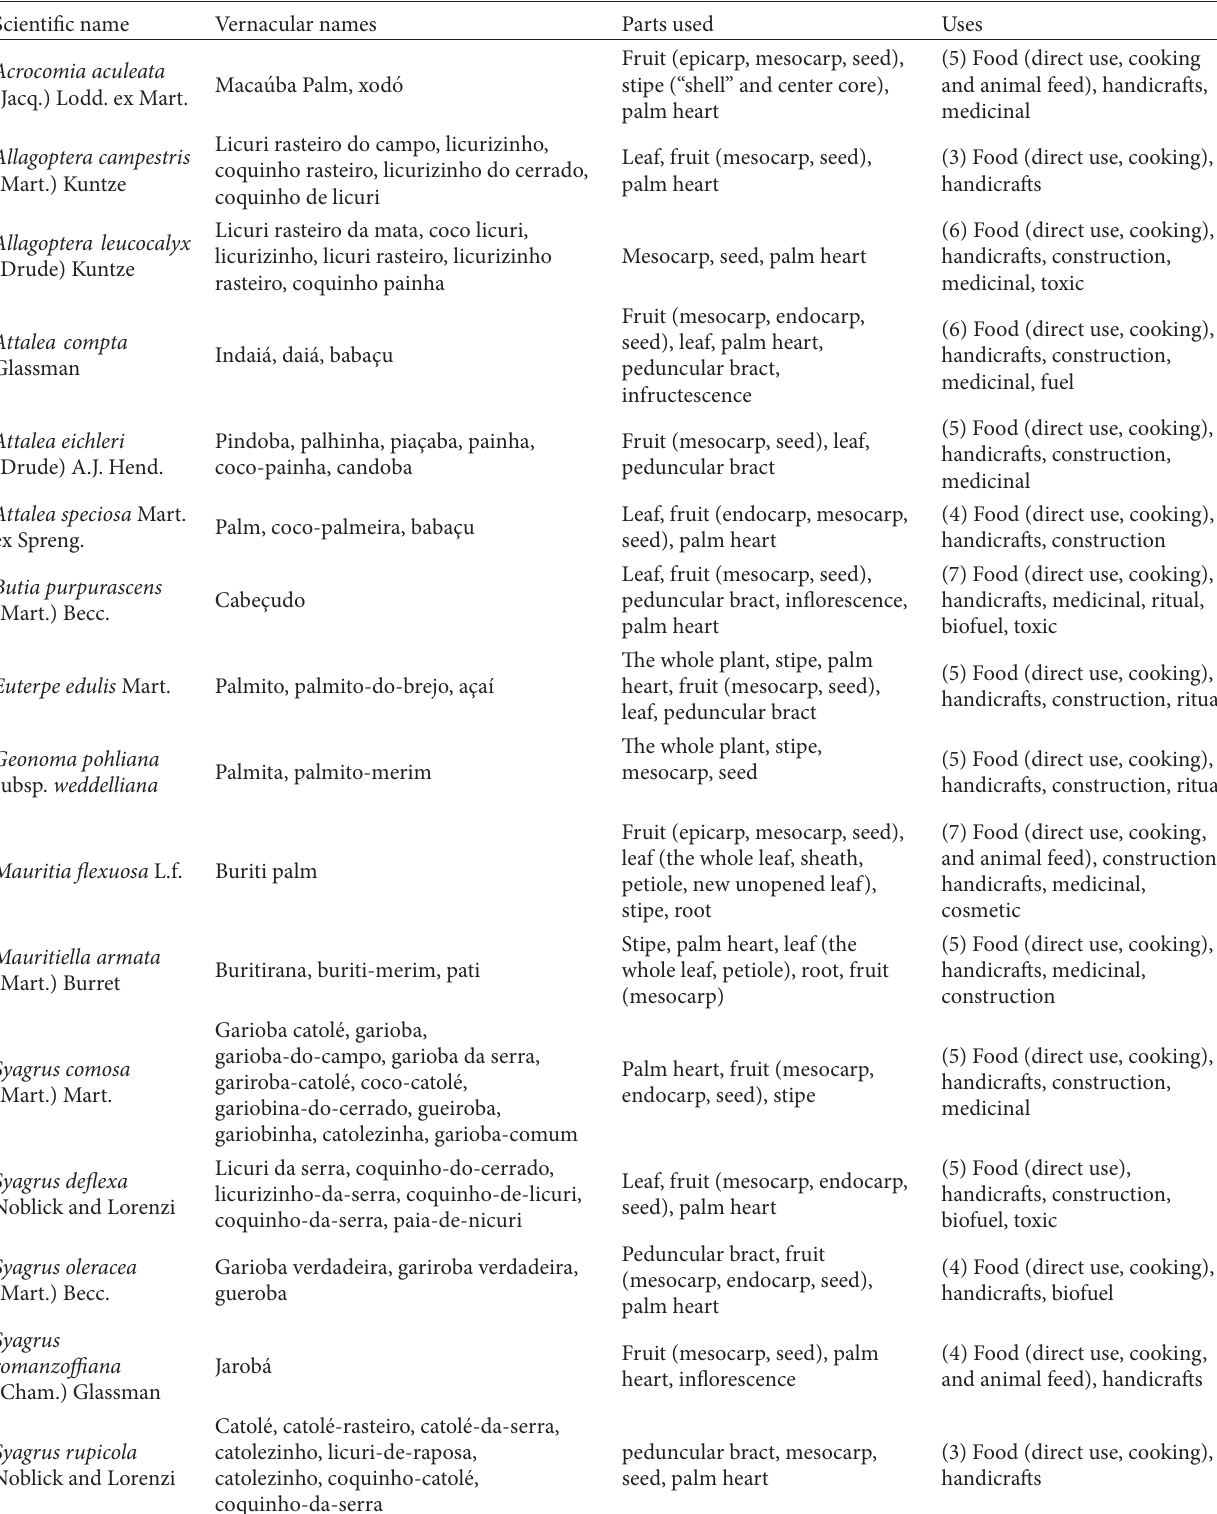
Table 3: List of species, common names, parts used, and the uses of palms in the Kalunga community Engenho II, Cavalcante, GO, central western Brazil. In the “Vernacular names” column, the bolded names indicate those most frequently used by the informants; in the “Uses” column, the number indicates the number of different uses for the